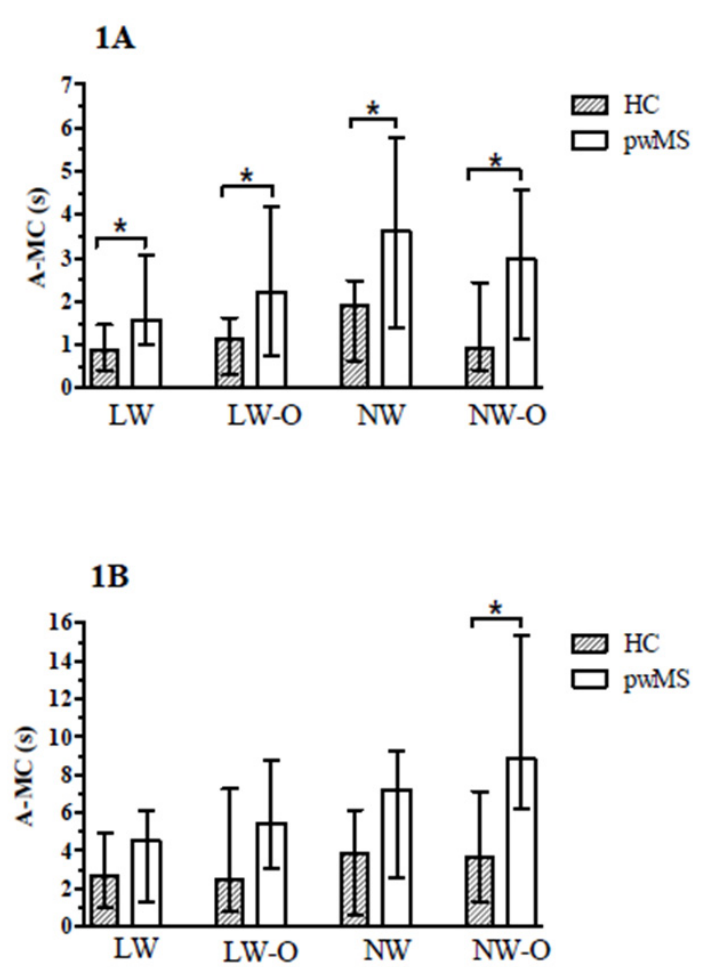
Figure 1. A-MC differences between pwMS and HC in ST ( 1A ) and DT ( 1B ) conditions. Legend: A-MC: absolute mental chronometry; HC: healthy controls; pwMS: people with multiple sclerosis; LW: large-width walkway; LW-O: large-width walkway with obstacles; NW: narrow-width walkway; NW-O: narrow-width walkway with obstacles; ST: single-task; DT: dual-task; * indicates a statistically significant difference ( p -value ˂ 0.05).